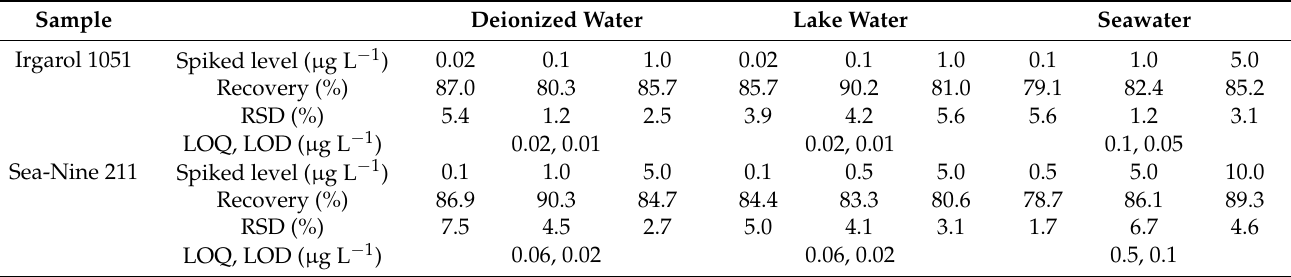
Table 1. Recoveries and RSDs of Irgarol 1051 and Sea-Nine 211 spiked in water samples ( n =